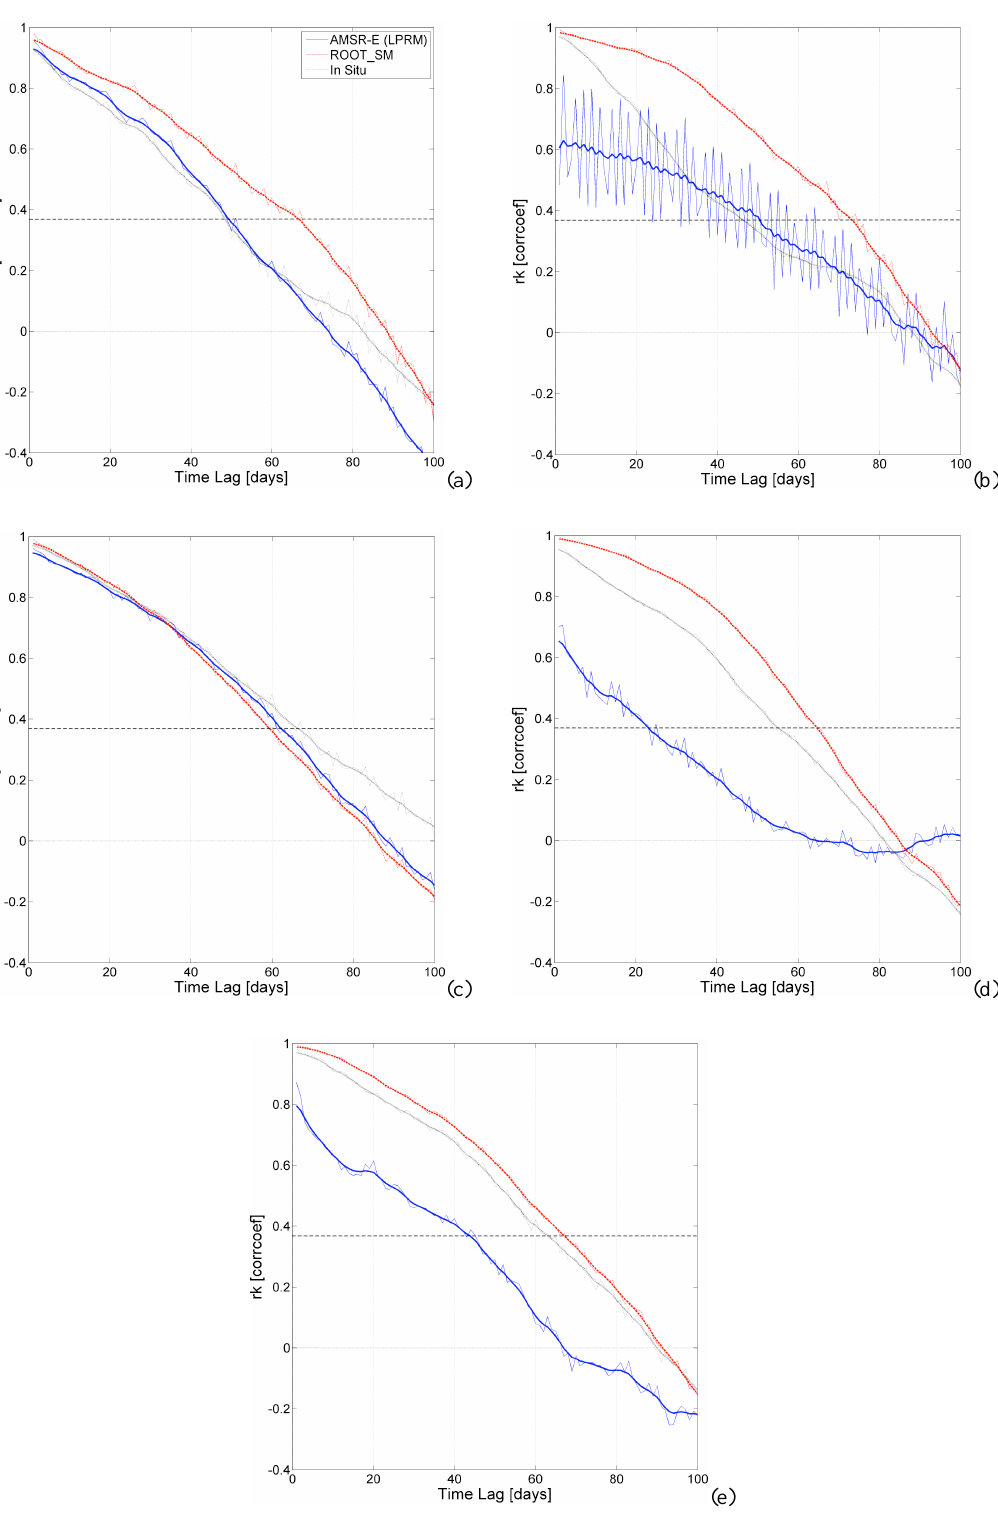
Fig. 4. Autocorrelation graphs of AMSR-E, ORCHIDEE ROOT SM and in situ FLUXNET soil moisture data of (a) Majadas del T, Spain (# 2), (b) Le Bray, France (# 4), (c) Mitra IV, Portugal (# 6), (d) Hainich, Germany (# 9) and (e) Metolius Pine, USA, (# 15). Black dashed horizontal line in autocorrelation graphs indicates where the rk value is equal to 1/ e , indicating the characteristic lag-time at the